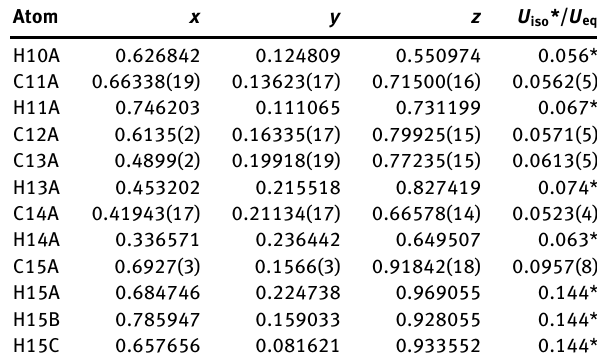
Table 2: Fractional atomic coordinates and isotropic or equivalent isotropic displacement parameters (Å 2